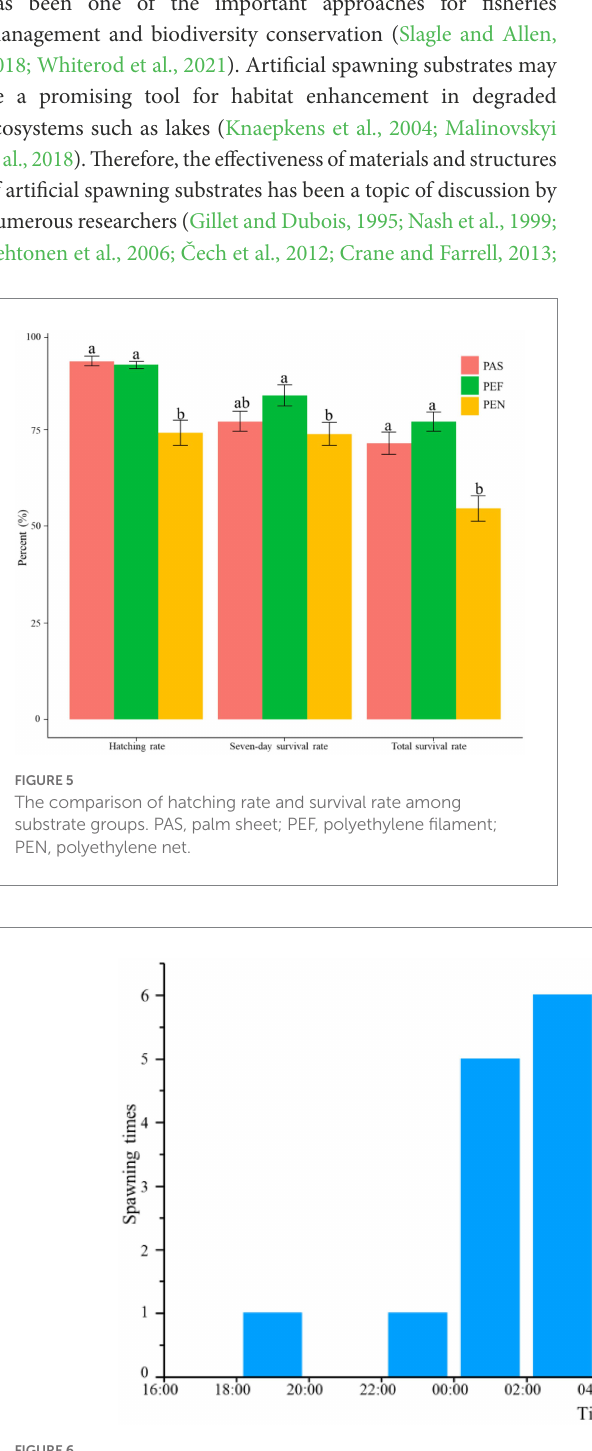
FIGURE 6 The temporal distribution of spawning occurrences in a full day. Spawning times represents the number of fish spawning observed by